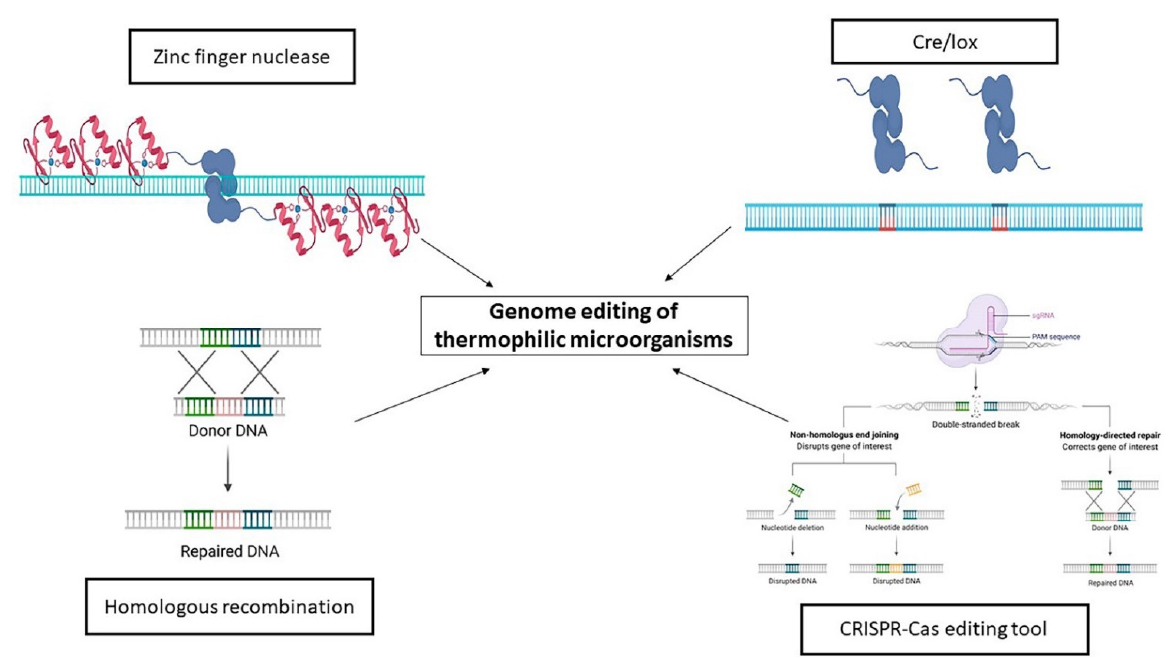
Figure 5. Schematic representation of the genome editing tools for thermophilic microorganisms. The Zinc finger nuclease is the first genome editing tool setup for thermophilic microorganisms. The most common is the spontaneous homologous recombination. In the last decades, the Cre/lox and CRISPR-Cas based tools were adapted for thermophiles (Created with BioRender.com (accessed on 20 January